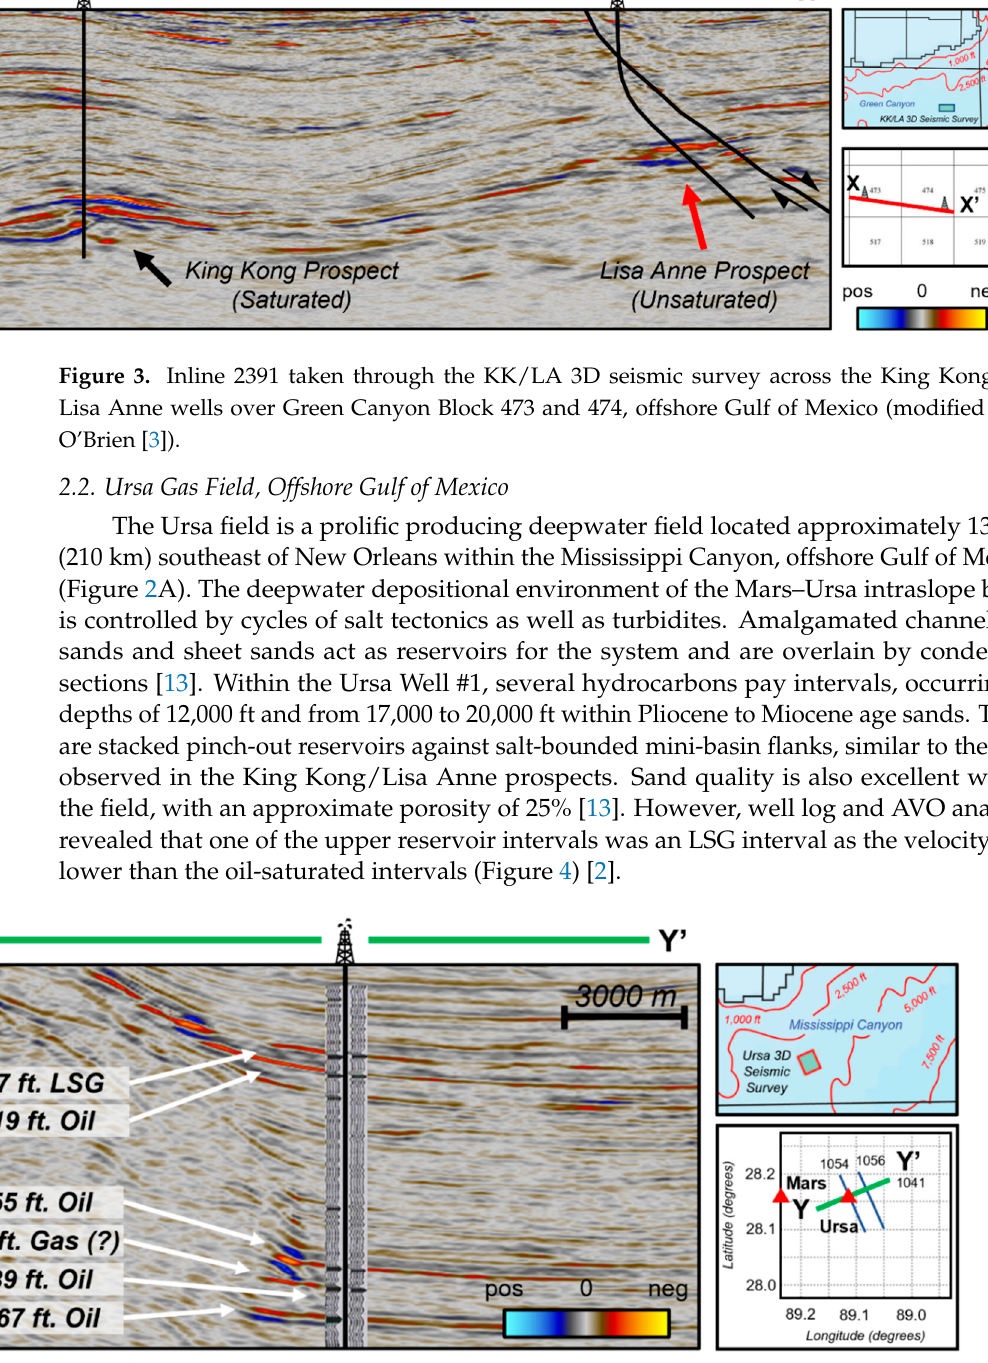
Figure 4. Inline 2804 taken through the Ursa Field 3D seismic survey. The hydrocarbon intervals and a synthetic from Hilterman, 2001 are highlighted on the seismic section. Notice how the amplitude for the LSG interval exhibits a similar response to the other hydrocarbon producing intervals (modified after Hilterman [2]).